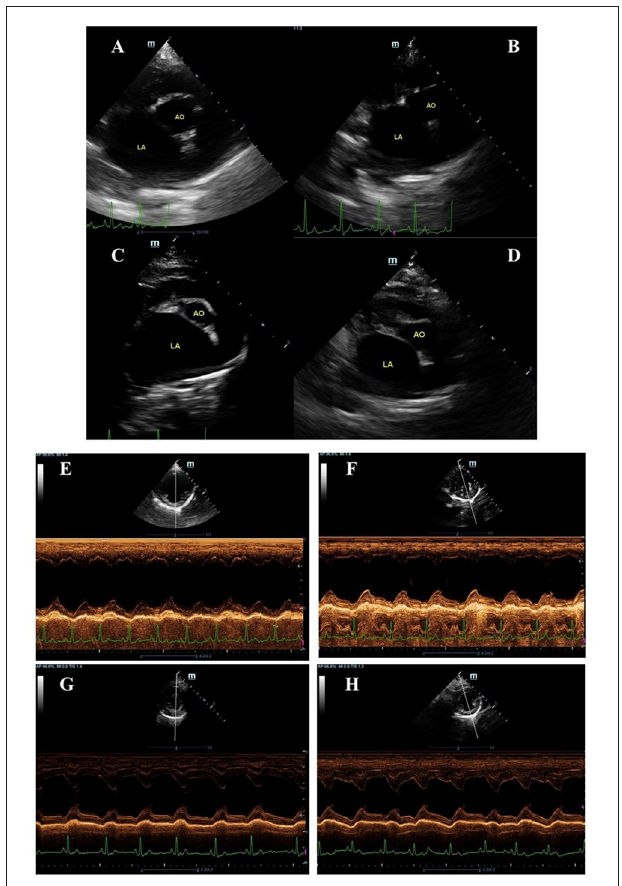
FIGURE 2 | Examples of two-dimension echocardiography of parasternal short axis view at the level of the left atrium and aorta (A–D) and M-mode (E–H) in symptomatic dogs with myxomatous mitral valve disease stage C before (A,C,E,G) and after (B,D,F,H) being given ramipril (A,B,E,F) sacubitril/valsartan (C,D,G,H) . The left atrium to aortic root ratio (LA/Ao) and left ventricular internal diastole diameter normalized to body weight (LVIDDN) were obtained via the right parasternal short-axis view and M-mode as described by Boswood and colleagues ( 19). The LA/Ao measurement was done by the “Swedish” method ( 25) while the LVIDDN measurement was done according to